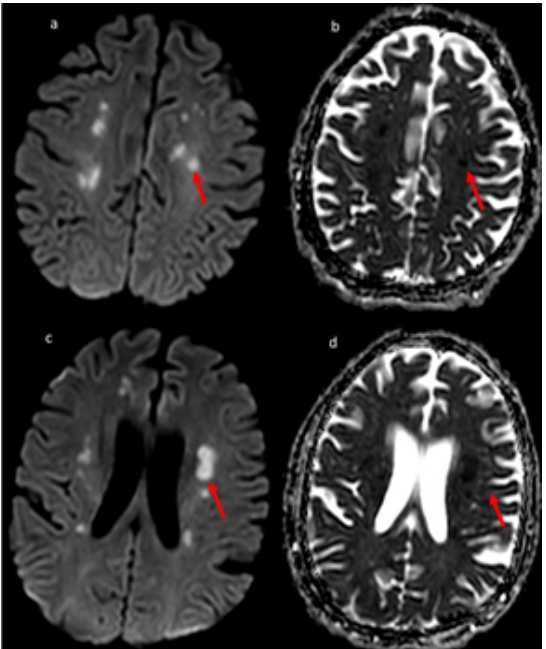
Figure 2. 51-year-old man COVID-19 RT-PCR positive presented with dysarthria and change in mentation. MR Diffusion image ( a ) showing multiple foci of restricted diffusion (red arrow) involving centrum semiovale with the corresponding hypointense signal on ADC image ( b ), suggestive of embolic infarcts. ( c ) Showing multiple small foci of restricted diffusion (red arrow) involving centrum semiovale and periventricular white matter with the corresponding hypointense signal on ADC image ( d ), suggestive of embolic infarcts.